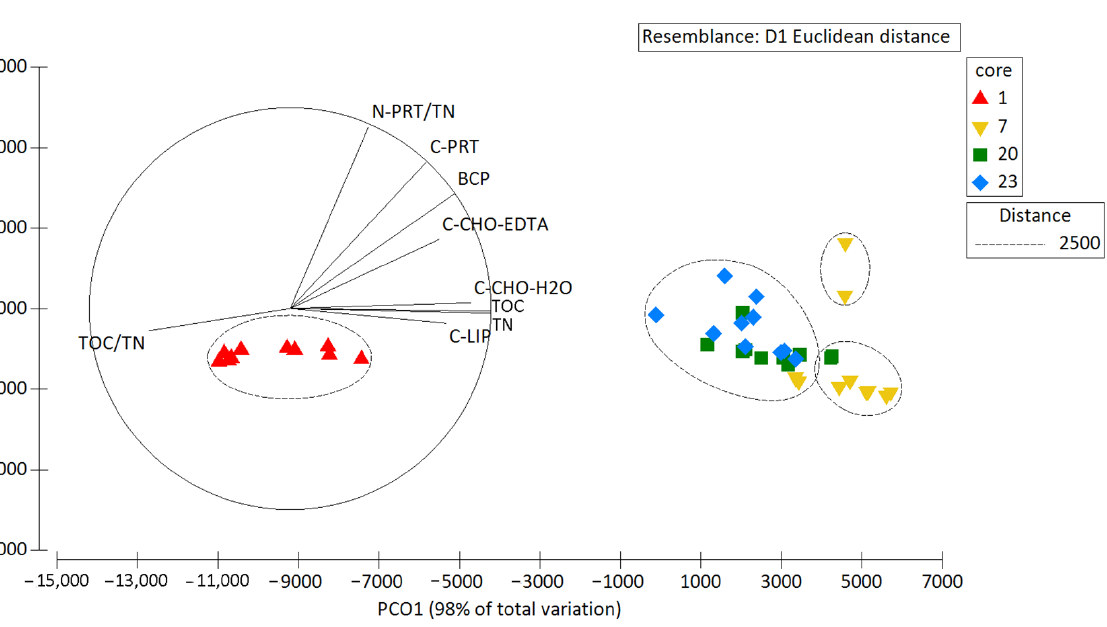
Figure 8. Hierarchical cluster analyses diagram resulting from the SIMPROF analyses of concentration of major organic components (TOC, TN, N-PRT, TOC/TN, C-PRT, C-LIP, C-CHO H2O , C-CHO EDTA ). The PCO1 axis (Figure 9) accounted for 98.9% of the total observed variation and clearly separated the four groups. PCO2 axis gathered 1% of the total variation. The superimposed vectors showed three sets of biochemical components of sedimentary organic matter, associated with different groups. Group-a included almost all samples (0–10 cm) of the site 01 collected at the outer shelf and it was characterized by the highest value of TOC/TN (Figures 3 and 9; Table 4). This group comprised 82 foraminiferal species, 23 of which were exclusively found in this site. The most characteristic species (species that cumulative contribute to the 25% of similarity within each group in SIMPER analyses) of this group were Melonis zaandami , Lagenammina sp. D 1 and Lagenammina difflugiformis .